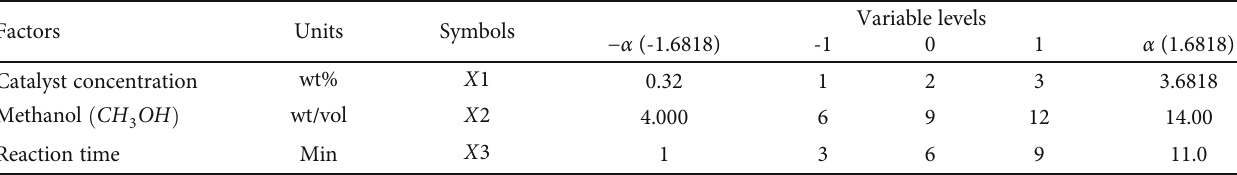
Table 1: Levels for independent variables for selected factors designed through CCD.